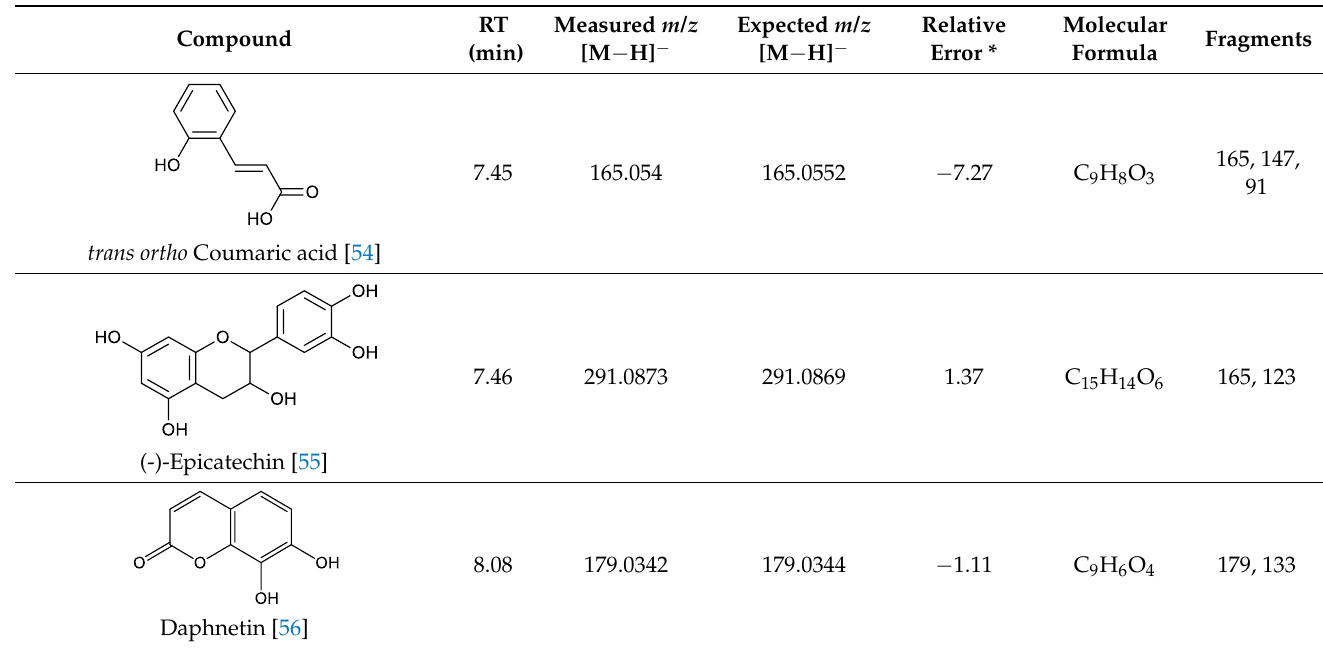
key amino acids inside the “B -cell lymphoma 2 (Bcl- 2), PDB ID: 4IEH”, while there